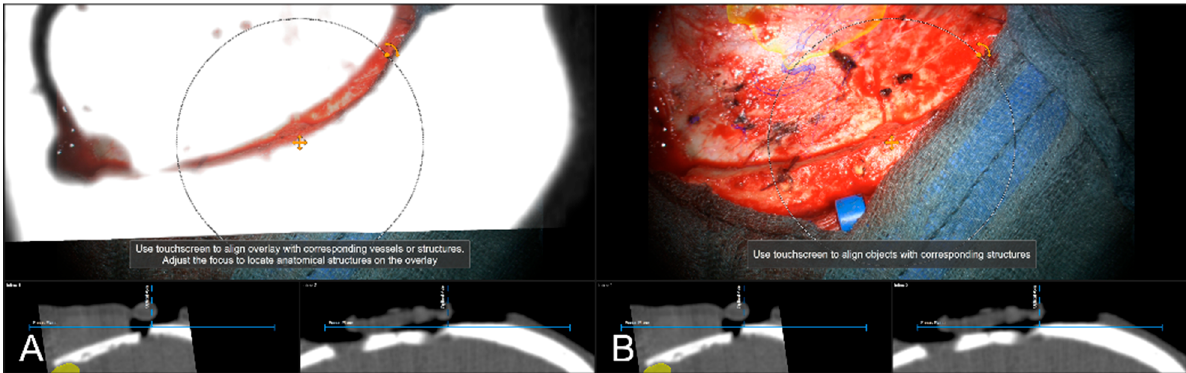
Figure 5. Using an intraoperatively conducted CT scan for automatic patient registration after craniotomy for evaluation of navigation accuracy showing a sufficient in-plane match of MIP ( A ) and patient anatomy ( B ). (In parallel view of MIP projection and patient anatomy (upper part) and inline views with the recent focus plane (blue line) and the optical axis (dashed blue line) in the bottom part).